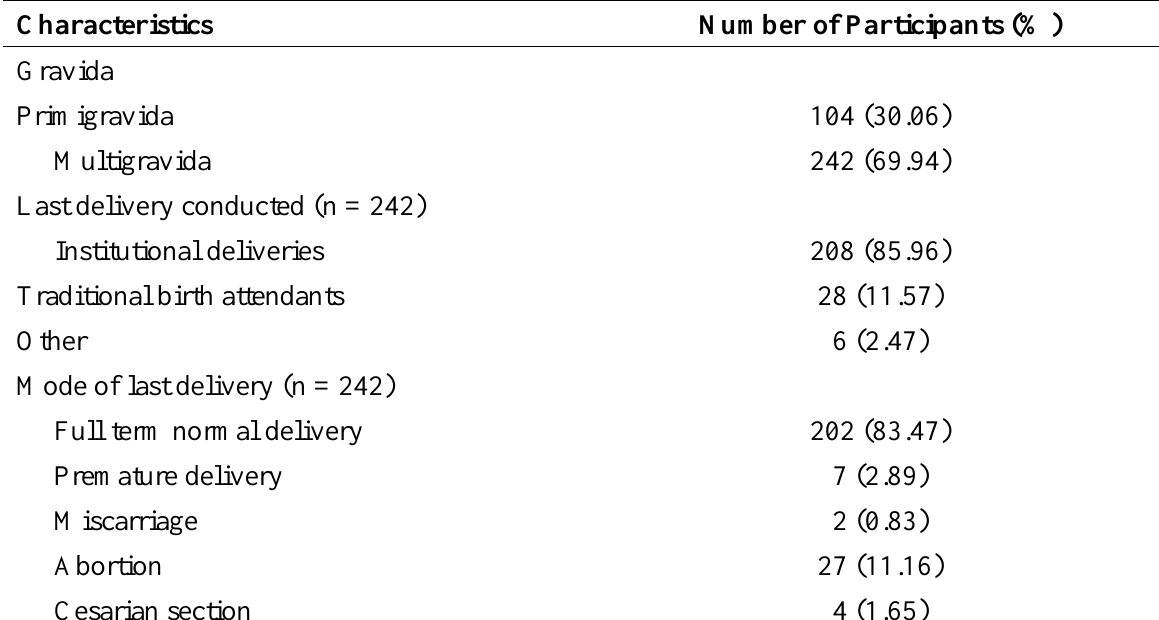
Table 2: Obstetric profile of study participants